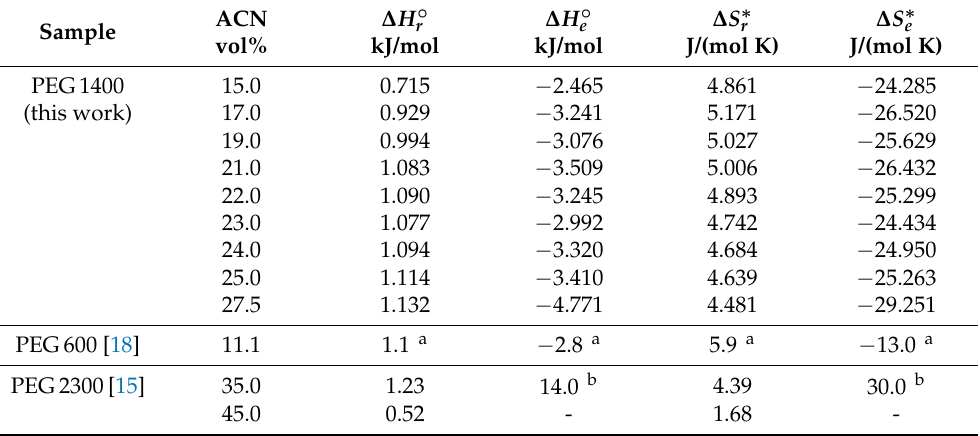
Table 1. Determined thermodynamic parameters as function of the acetonitrile content (ACN) of the mobile phase and comparison to literature data.